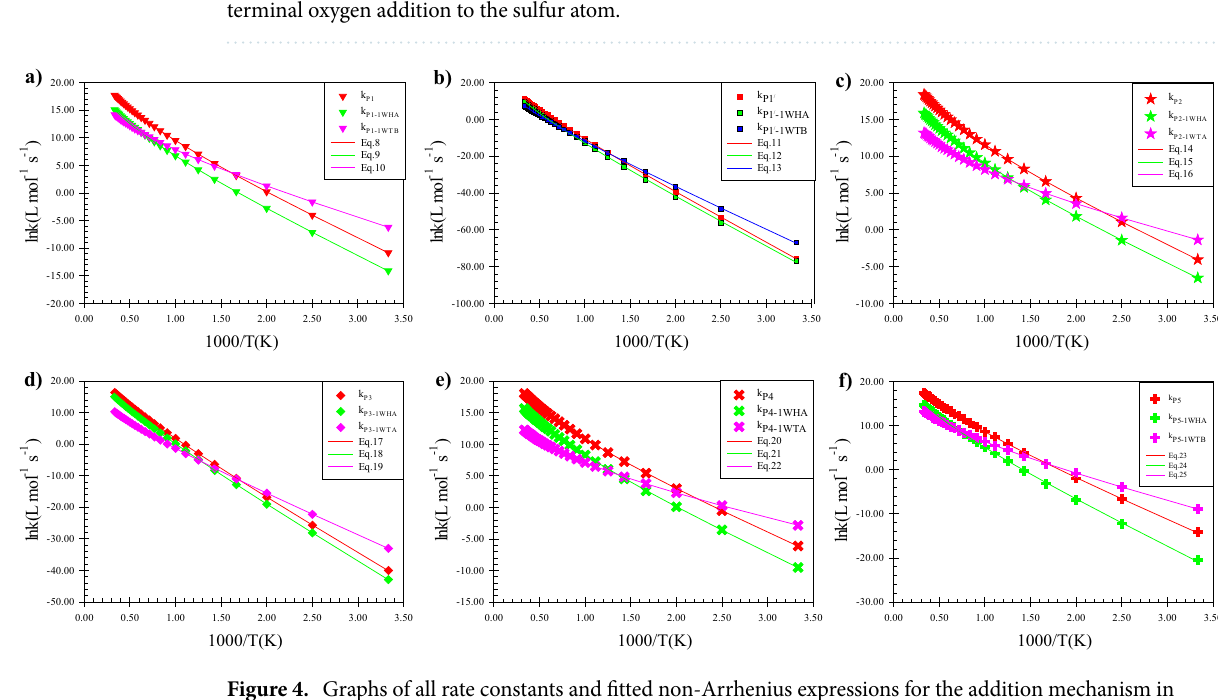
Figure 4. Graphs of all rate constants and fitted non-Arrhenius expressions for the addition mechanism in the thiophene + HO 2 , thiophene + 1WHA, 1WTA + HO 2 , and 1WTB + HO 2 reactions obtained at the BD(T)/6– 31 + G(d,p) level of theory. ( a ) The terminal oxygen addition to β-C. ( b ) The middle oxygen addition to β-C. ( c ) The terminal oxygen addition to α-C. ( d ) The terminal oxygen addition to sulfur atom. ( e ) Ring-opening pathway. ( f ) Epoxy formation